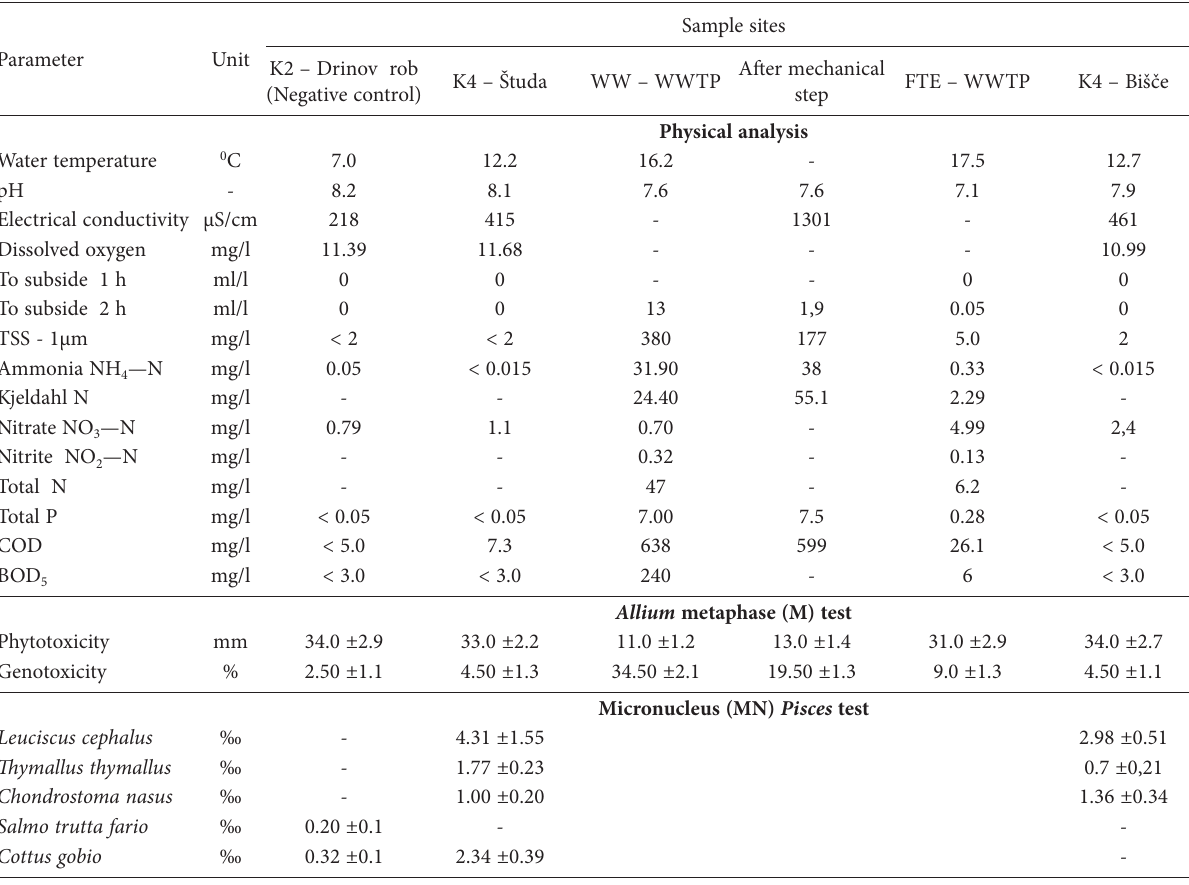
Table 3. United parameters physical quantities;cytological effects of the investigated samples survey – the genotoxicity level (damage to chromosomes) and general toxicity - phytotoxicity (root length inhibition) on the test onion plant A. cepa and Pisces micronuclei